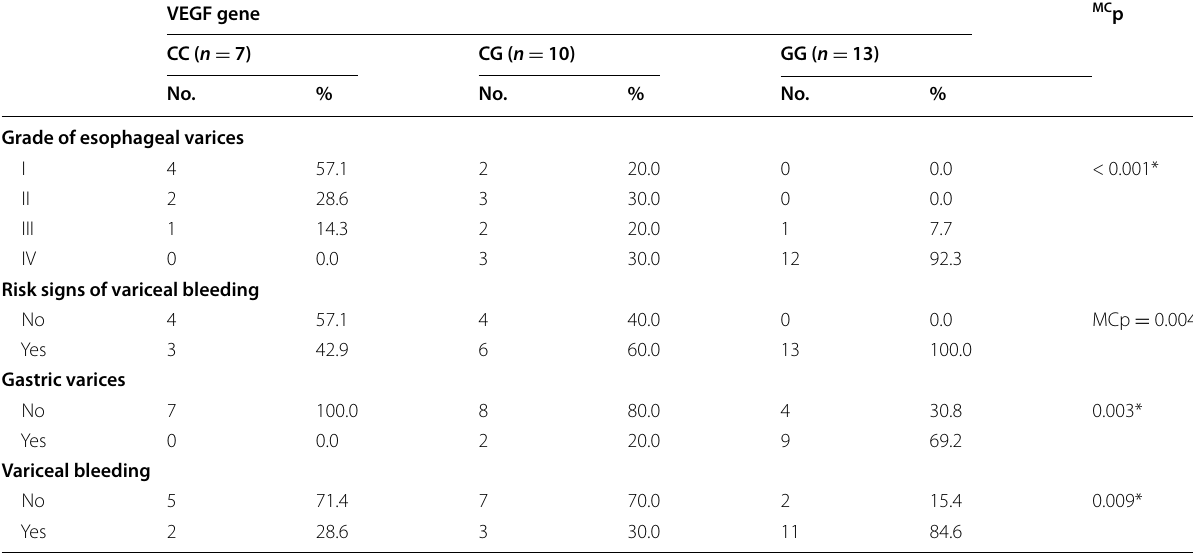
χ 2 Chi square test, MC Monte Carlo, p p value for comparing between different categories *Statistically significant at p ≤